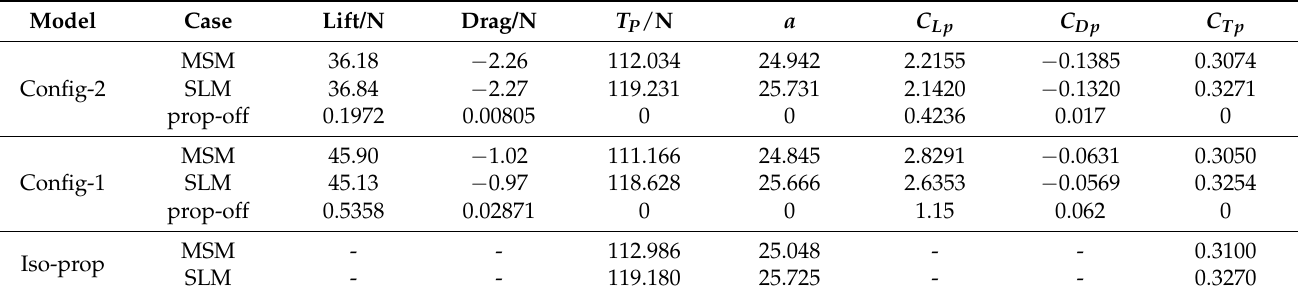
Table 2. Performance of single-propeller channel wing with different